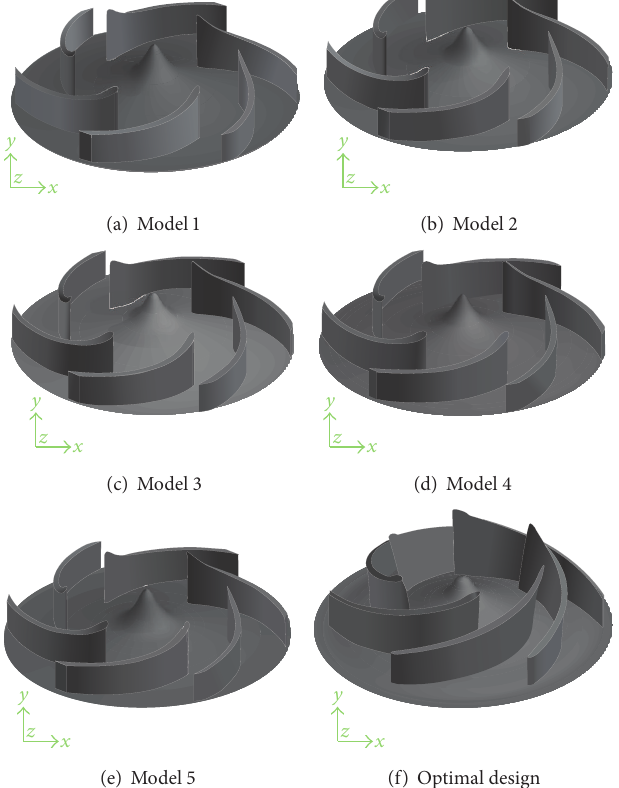
Figure 8: Geometry models of impellers.